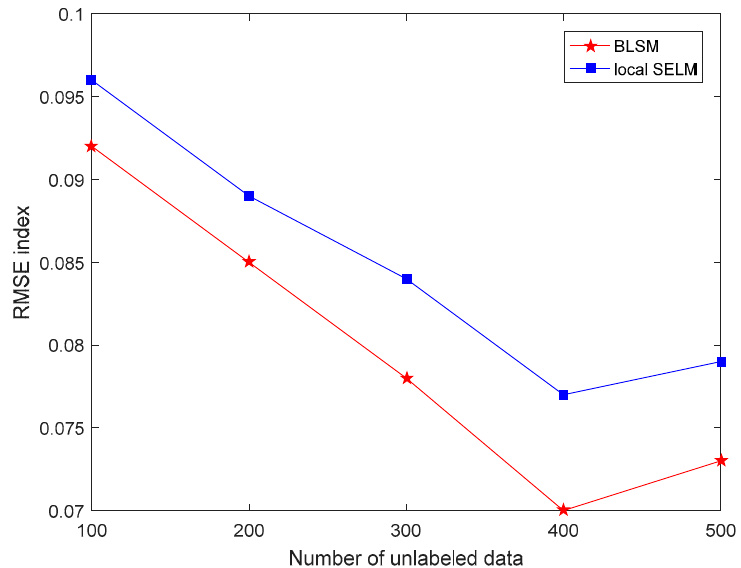
Figure 2. Root mean square error (RMSE) comparison of the silicon content prediction between bagging local semi-supervised models (BLSM) and local semi-supervised extreme learning machine (SELM) models with di ff erent numbers of unlabeled